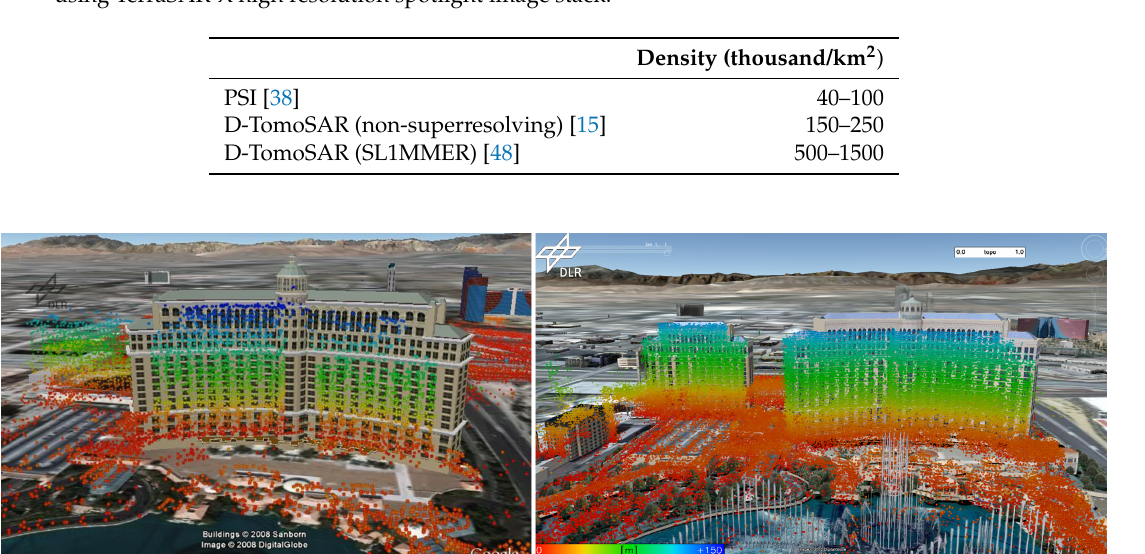
Figure 3. Comparison of the density of the 3D point cloud retrieved by PSI ( left ) and TomoSAR ( right ) of Bellagio Hotel, Las Vegas [8].